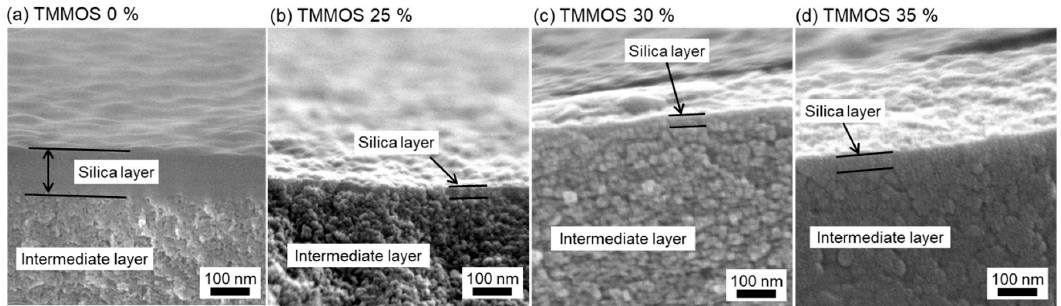
Figure 7. Scanning electron microscope (SEM) images of cross section of membranes ( a ) TMMOS 0%, ( b ) TMMOS 25%, ( c ) TMMOS 30%, and ( d ) TMMOS 35%.